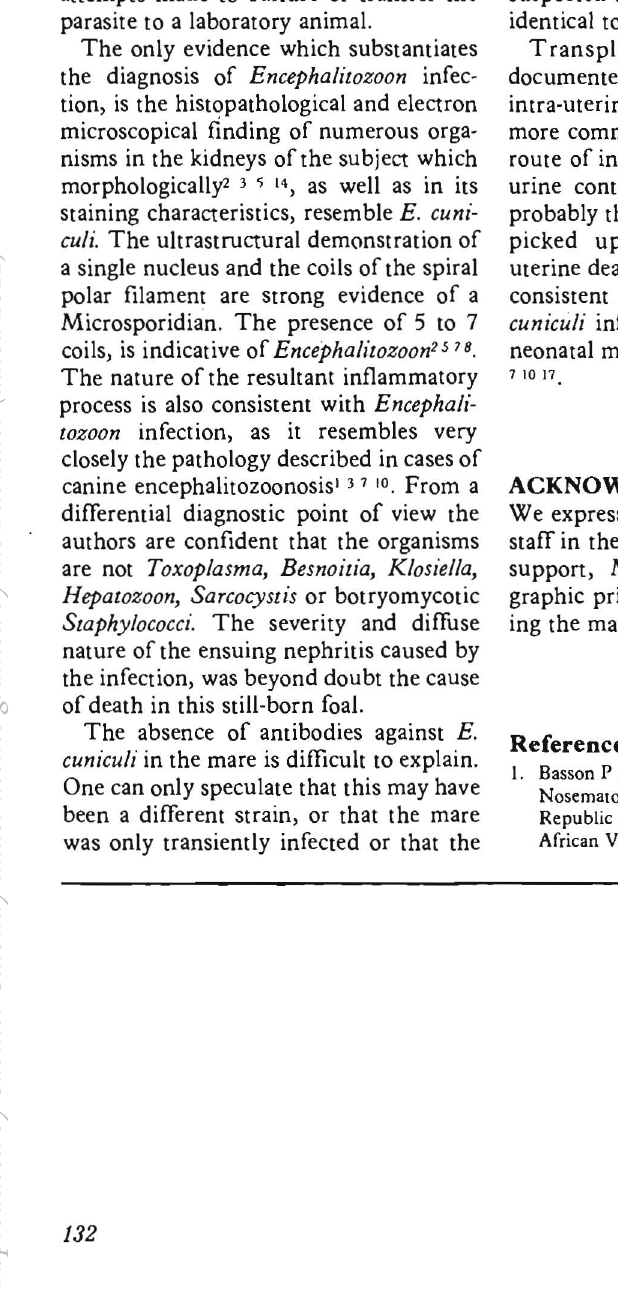
Fig. 4: Free-lying Encephalitozoo" organisms in an area of lym phoplasmacytic nephritis (arrow). Gram's X